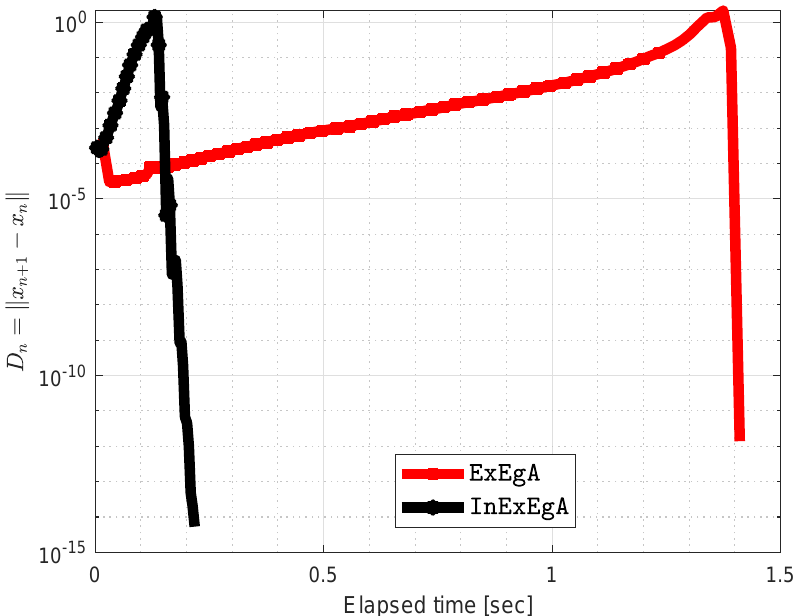
Figure 14. Algorithm 1 comparison with Algorithm 1 in [16] and elapsed time in seconds are 1.3294 and 0.1701